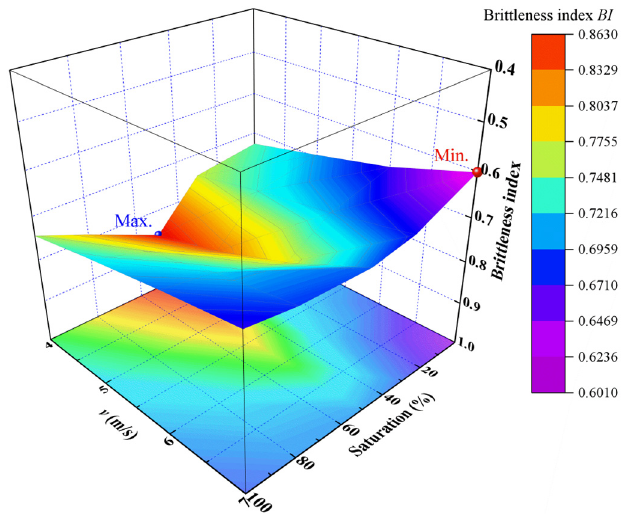
Figure 14. BI values versus impact velocity and saturation of the sample.